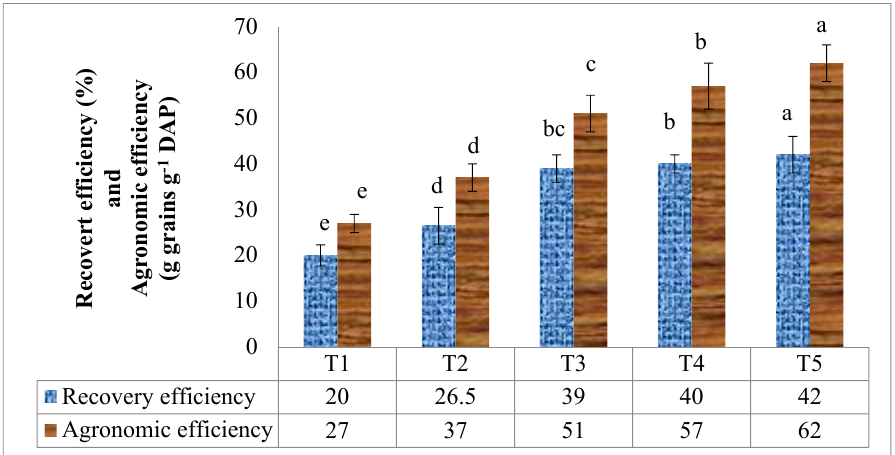
Figure 3. Efficacy of polymer-bioaugmented PsJN coated DAP on phosphorus use efficiency Figure 3. E ffi cacy of polymer-bioaugmented PsJN coated DAP on phosphorus use e ffi ciency parameters of wheat in a pot experiment. Note: Values sharing the same letter(s) did not di ff er significantly at